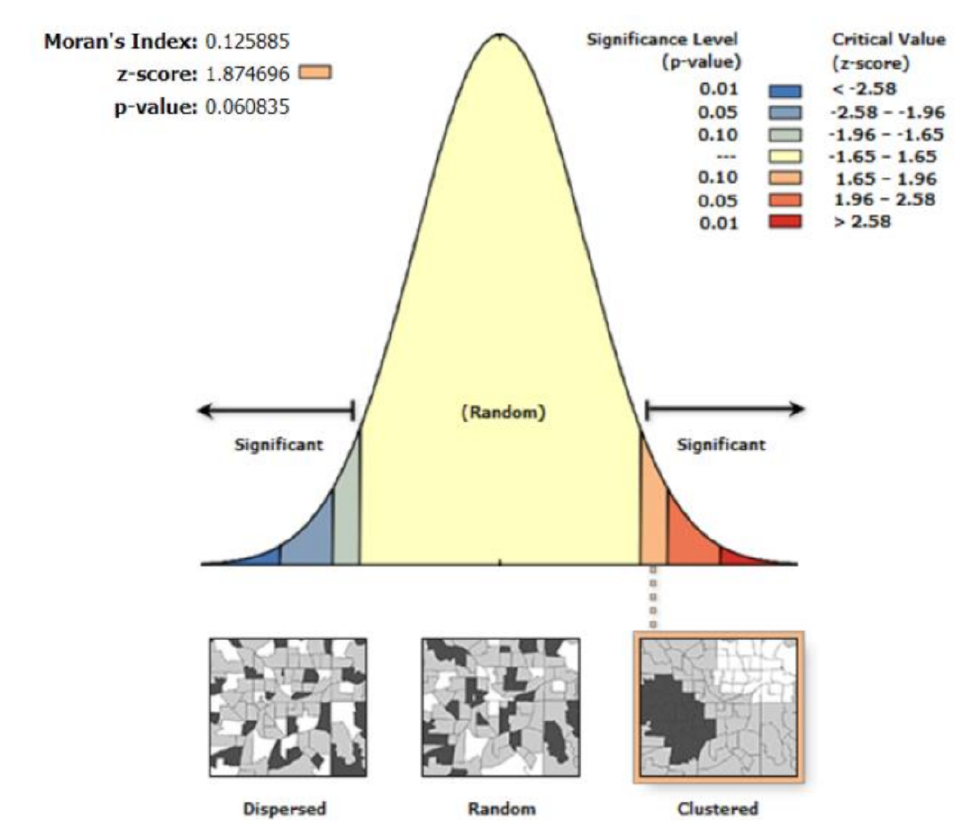
Figure 7. Spatial autocorrelation